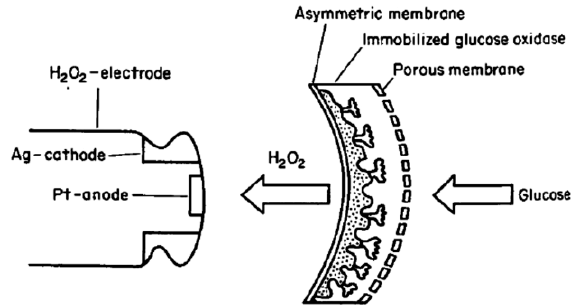
Figure 1. Scheme of the immobilized glucose oxidase membrane electrode.